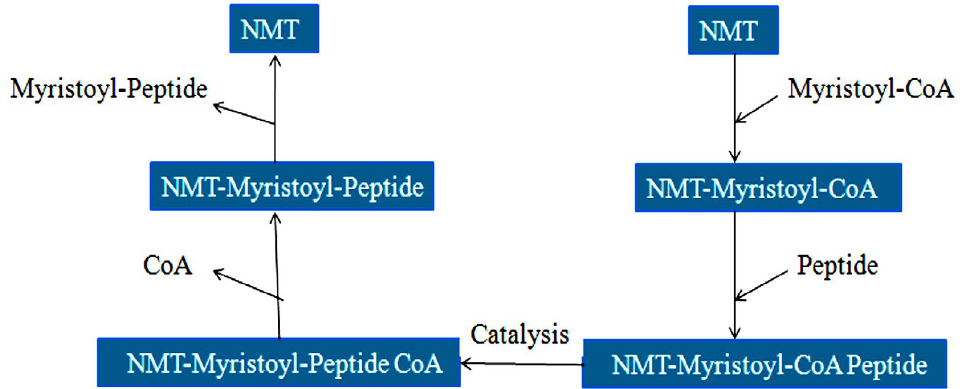
Fig. 4. The catalytic mechanism (Bi-Bi Reaction) of